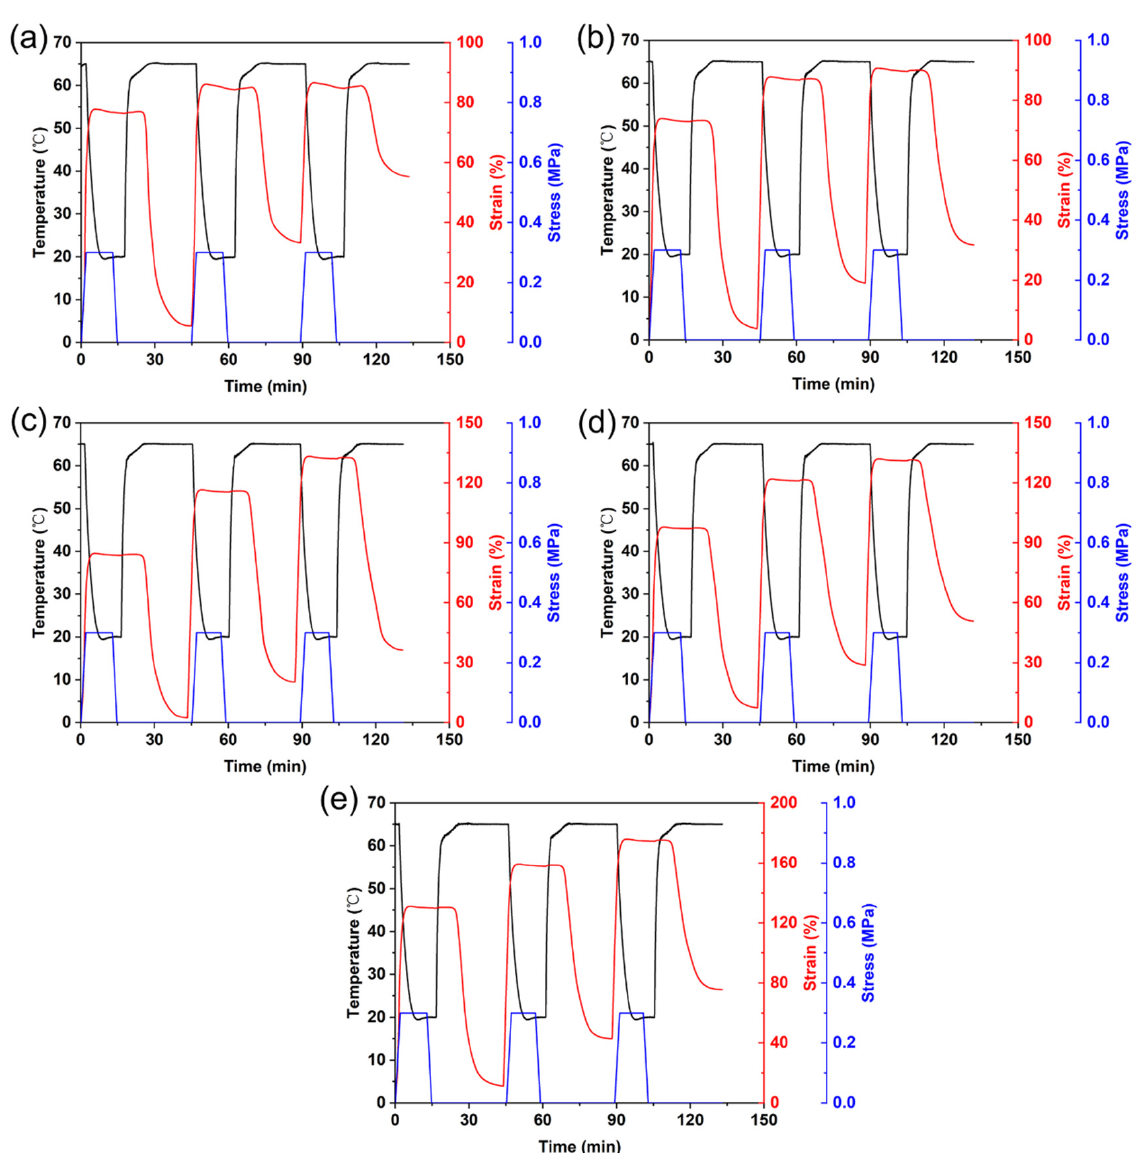
Figure 4. Temperature, strain, and stress curves of the PCL-NCO modified PLA/PCL blends during the three shape memory cycles: ( a ) PN0, ( b ) PN2, ( c ) PN4, ( d ) PN6, and ( e ) PN8. Table 2. R fn and R rn of the PLA/PCL blends with different PCL-NCO contents.